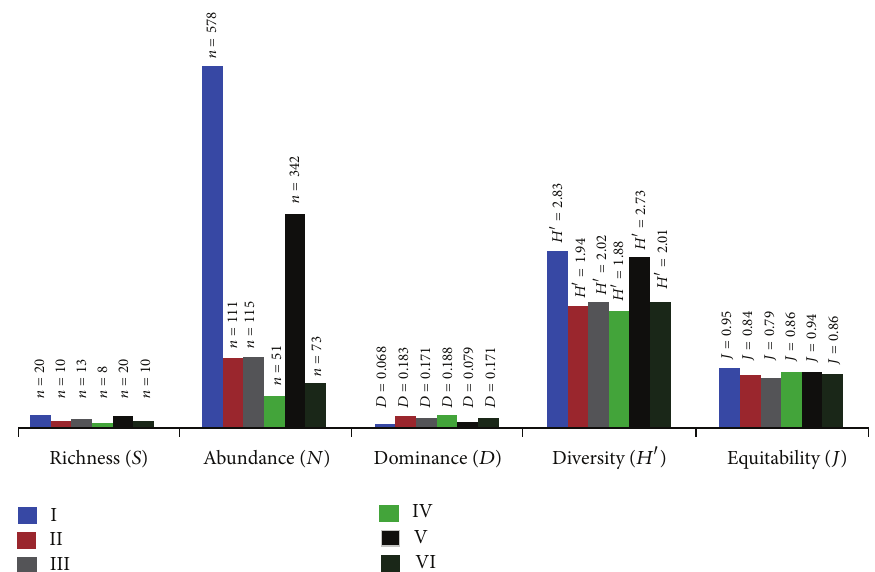
Figure 2: Ecological indices of the ichthyofauna from intertidal zone of the Macap´a waterfront in northern Brazil.